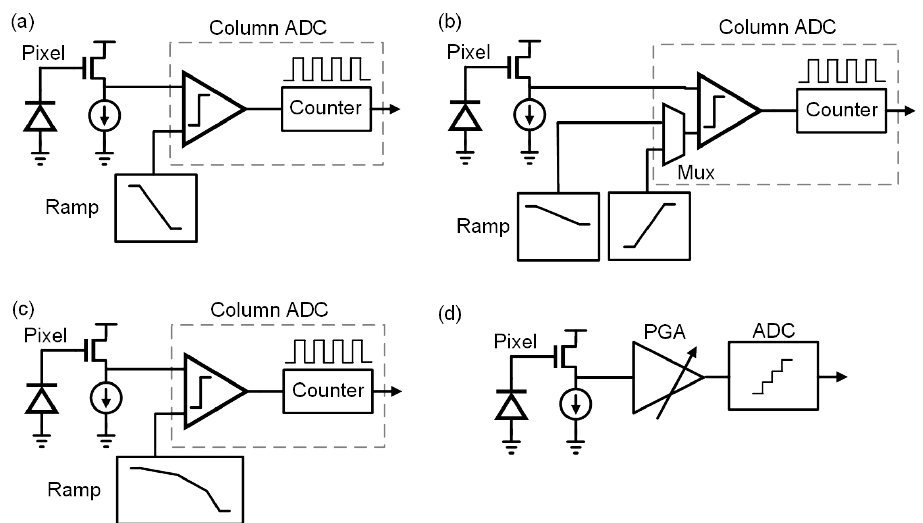
Figure 4. Block diagram of column-parallel ADCs. ( a ) conventional SS-ADC; ( b ) multiple-ramp ADC; ( c ) nonlinear-slope ADC; ( d ) gain adaptive ADC with a PGA.